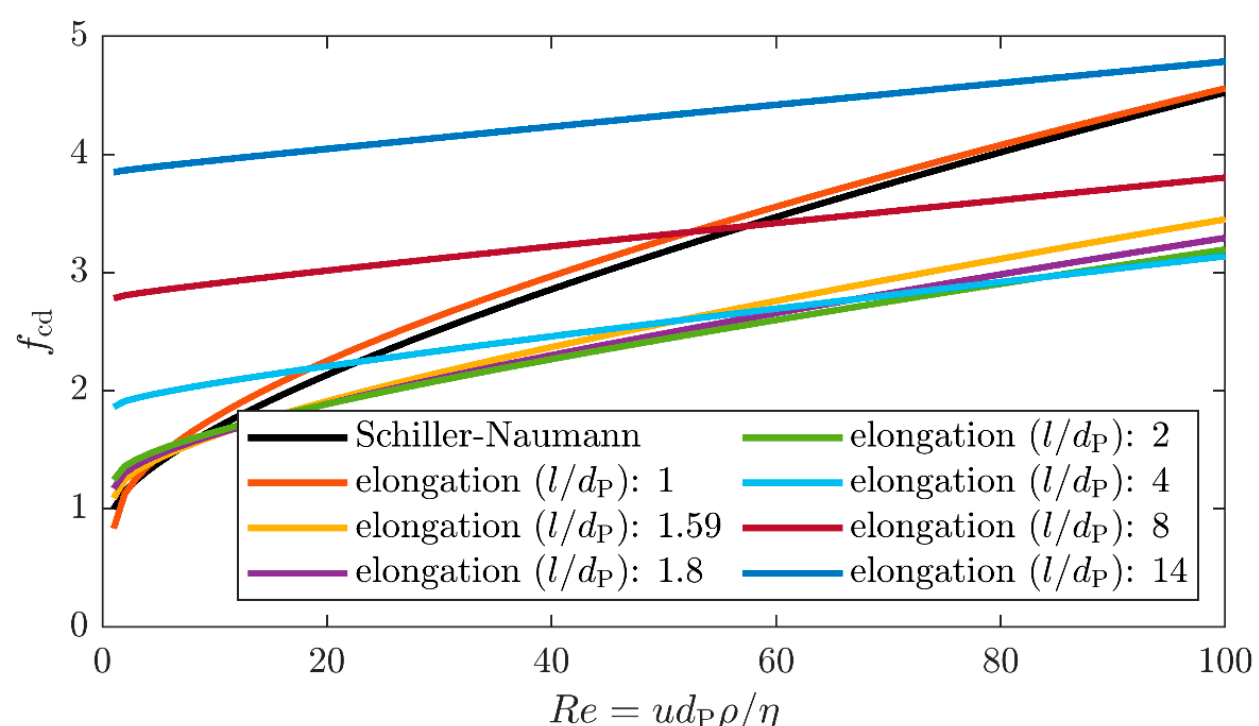
Figure 6. Visualization of the correction factor as a function of the deformation ratio. The increased flow force within the range of 𝐶𝑎 (cid:3408) 2 was considered in the Kalb model as described by Walzel [16].